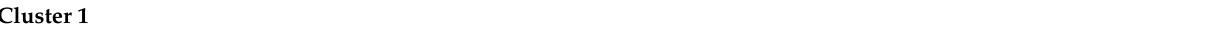
Table 1. Quantitative compilation of the parity composition of the exhalation phase.